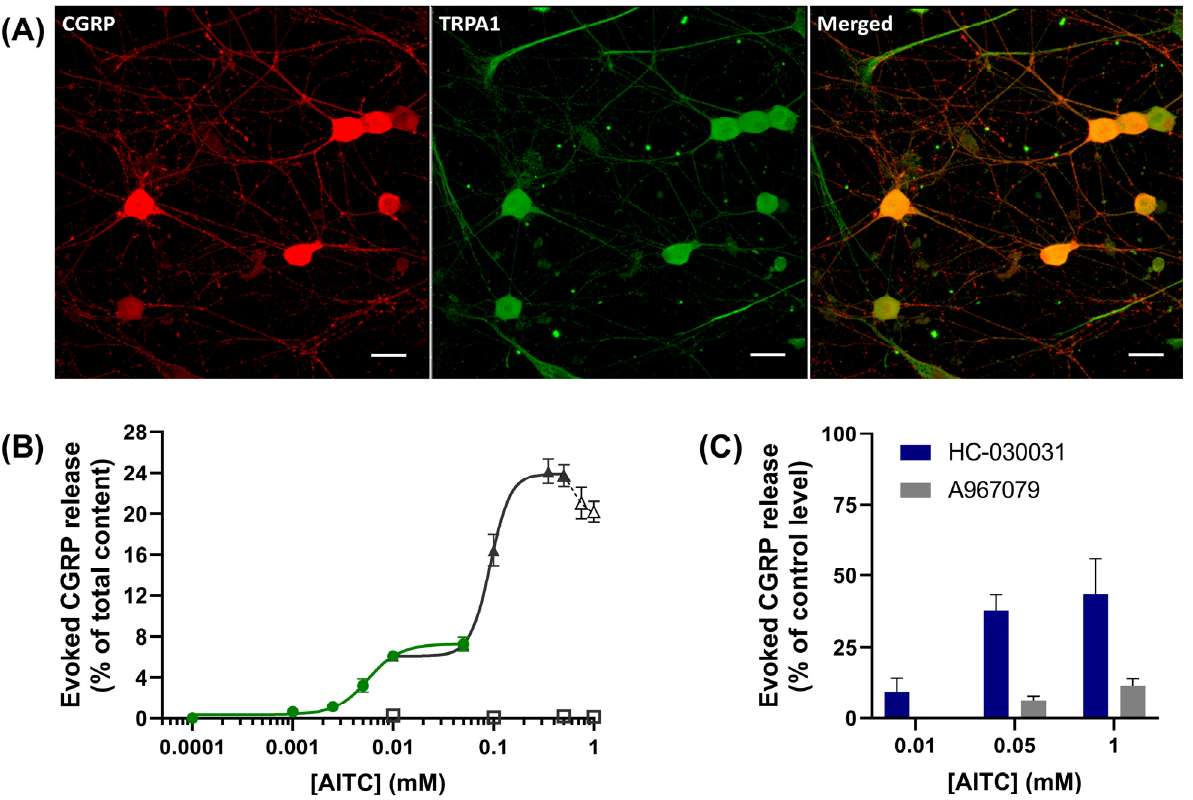
Figure 1. Allyl isothiocyanate (AITC) induces Ca 2+ -regulated release of calcitonin gene-related peptide (CGRP) from trigeminal ganglion neurons (TGNs) apparently via high- and low-affinity mechanisms, which are susceptible to TRPA1 antagonists HC-030031 or A967079. ( A ) Immuno-cytochemistry with confocal microscope imaging was performed on the TGNs as described in the Section 4 to detect the expression of CGRP (red) as well as TRPA1 (green) and assess their co-expression (merged). Scale bars represent 20 µ m. ( B , C ) Cultured TGNs were exposed for 30 min to each [AITC]. Secreted and residual intracellular CGRP were quantified by ELISA as detailed in the Section 4. ( B ) The dose-response relationship between [AITC] and CGRP release (expressed as a % of the total CGRP content) was fitted with two separate four-parameter logistic functions (green, 0.0001–0.05 mM AITC and black, 0.01–0.5 mM; see Section 4). The response peaked at 0.35 mM AITC and declined for concentrations higher than 0.5 mM; data points between 0.5 and 1 mM AITC, connected with a broken line, were not included in the fitting. The quantities of CGRP released into Ca 2+ -free HEPES buffered saline (HBS) containing 2 mM EGTA by the presence of 0.01, 0.1, 0.5, or 1 mM AITC are plotted with squares; N ≥ 3, n ≥ 6. ( C ) TGNs were exposed to 100 µ M HC-030031, 100 µ M A967079, or vehicle only for 30 min before and during stimulation with various [AITC]. After subtraction of the spontaneous efflux, the amounts of CGRP released were calculated as detailed in the Section 4 and plotted (blue bars, HC-030031; grey bars, A967079) as a % of the requisite control (vehicle only) level elicited by each [AITC]; N = 2, n ≥ 6. Data are presented as mean ± standard error of the mean (s.e.m.); error bars are not shown where they are smaller than the associated symbol.